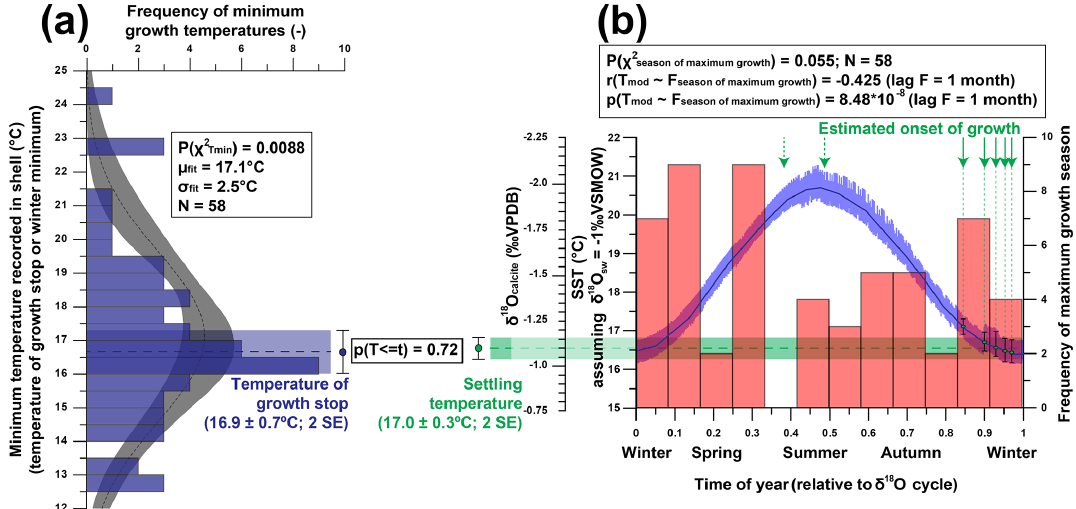
Figure 11. Overview of statistical evaluation of growth parameters of R. diluvianum derived from age modeling in shells 1–5. (a) Histogram of minimum temperatures of growth (equivalent to the time at which growth stops or the minimum yearly temperature) in R. diluvianum , showing that the temperature at which growth slows coincides with the time of first growth at post-larval settlement ( p = 0 . 717). (b) His- togram of the season of maximum growth relative to the δ 18 O seasonality cycle shows no significant concentration towards a favorable growing season, while moments of first growth (following settlement after the larval stage) are significantly concentrated towards the high- δ 18 O